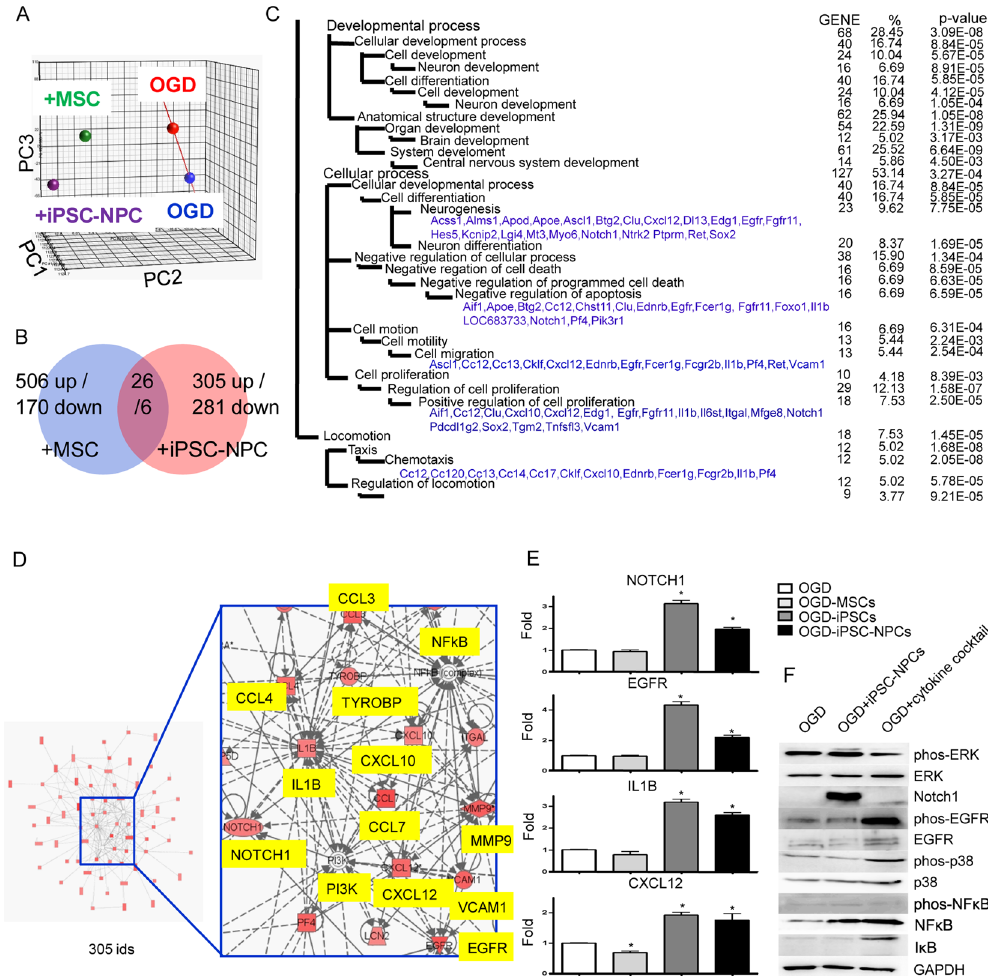
Figure 6. Comparative and interaction network analyses as a framework for iPSC-NPC-induced neuroprotection. ( A ) A principle component analysis plot using the entire set of 54,600 probes represented on the chips. ( B ) A Venn diagram illustrates that 305 probe sets were more abundantly expressed in rat cells co- cultured with iPSC-NPCs. ( C ) Altered biological modules in rat cells co-cultured with iPSC-NPC according to the Gene Ontology database. The significantly enriched number of genes, gene symbols, and P -values are listed ( P < 0.05). ( D ) A functional genetic network composed of the above 305 probe sets. This network is graphically displayed as nodes (gene products) and edges (biological relationships between nodes) mapped by the Ingenuity TM Pathway Analysis tool. The intensity of the node color indicates the degree of upregulation. Left panel: the core region of this gene network, highlighting several hub genes. ( E ) Validation of the array data by RT-qPCR. Mean expression levels of target genes were compared with GAPDH as a control. Each bar represents a different group. The results are expressed as mean ± SD. ( F ) The protein immunoblot analysis of rat cells subjected to OGD-alone and those that were treated with either iPSC-NPCs or the cytokine